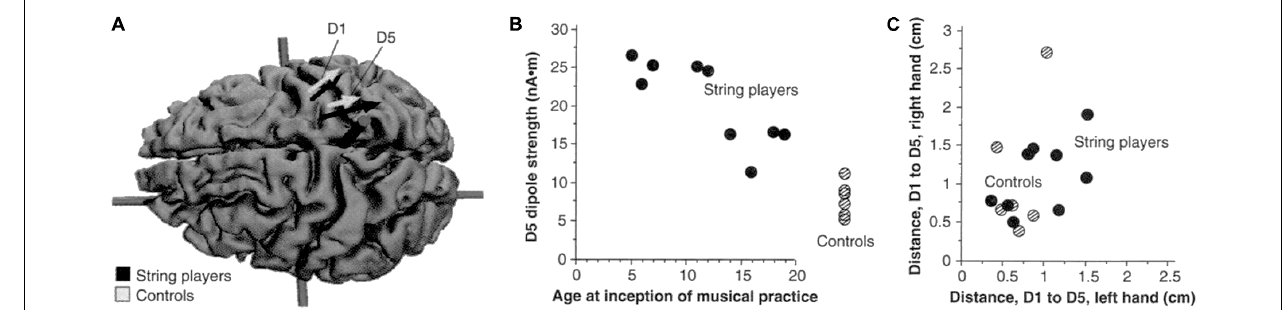
D5 than for Dl. The dipole moment is also larger for the musicians’ D5, as indicated by the greater magnitude of the upper arrow. (B) The magnitude of the dipole moment as a function of the age of inception of musical practice; string players are indicated by filled circles, control subjects by hatched circles. Note the larger dipole moment for individuals beginning musical practice before the age of 12. (C) Scatterplot of the Euclidean distances (in centimeters) between the cortical representations of Dl and D5. This distance for the musicians’ left hands was greater than that in controls, but this difference is not statistically significant. Reprinted from Elbert etal.